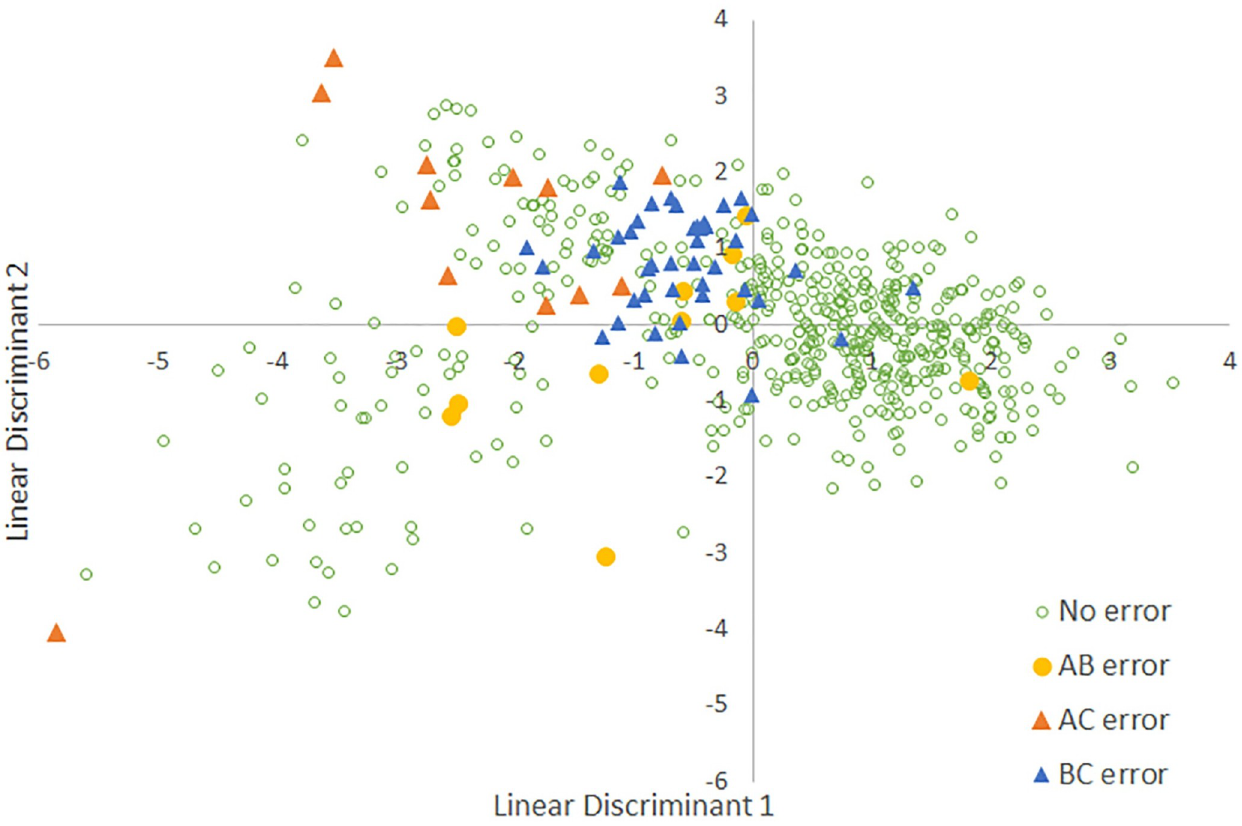
Fig 4. Errors between manual song type assignments and song type assigned by the Linear Discriminant Analysis. “No error” indicates song types with a match between assigned song type and Linear Discriminant Analysis assignment. “AB error” indicates song types that were classified by one method as A and by the other method as B. “AC error” and “BC error” map errors between those respective pairs of song types.